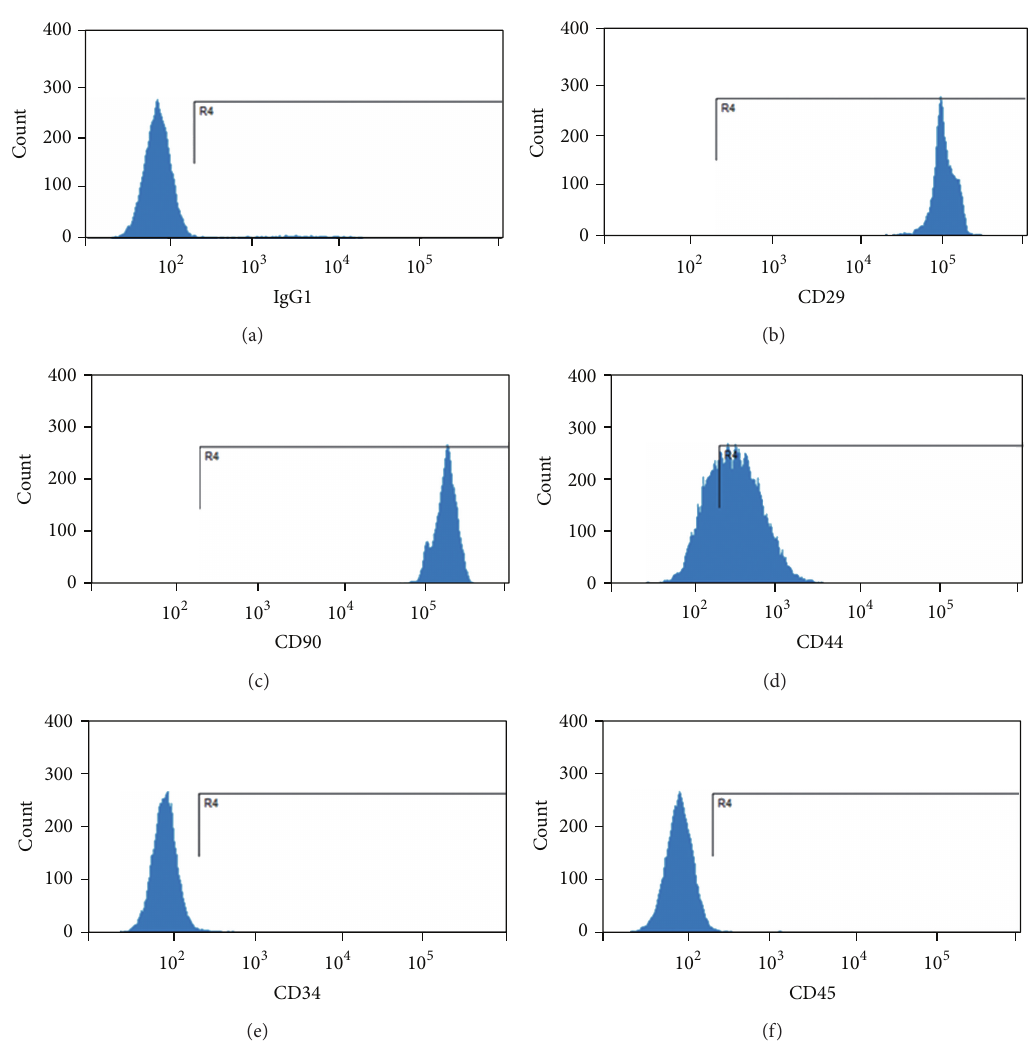
Figure 2: The surface marker expression of genetically modified rat MSCs. The expressions of selected surface markers of the modified MSCs were analyzed by flow cytometry. Mouse IgG1 was used as an isotype control (a); in the genetically modified MSCs, CD29, CD90, and CD44 were highly expressed ((b)–(d)) while the markers for hematopoietic stem cells, CD34 and CD45, were not expressed ((e) and